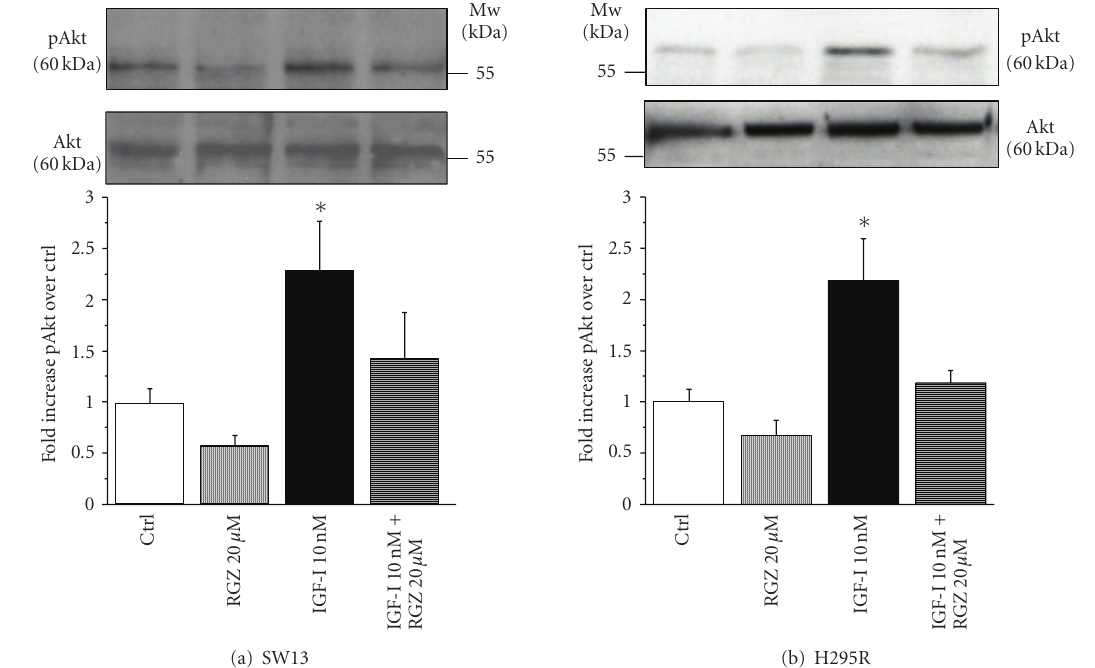
Figure 4: RGZ blunts IGF-I stimulation of Akt phosphorylation/activation . Western blot analysis of SW13 (a) and H295R (b) cell lysates following 15-minutestimulation with 10nM IGF-I and 20 μ M RGZ, reveals an increased phosphorylation of Akt in Ser473 following IGF-I, which is reverted by RGZ. Lane protein normalization for Akt is shown in the middle panels. Molecular weight markers are indicated. Mean ± SE of phospho-Akt band intensity over Ctrl is shown in 4 independent experiments for SW13 (a) and H295R (b) cells (lower panels). Statistical significance: ∗ P < . 05 versus Ctrl or IGF + RGZ.